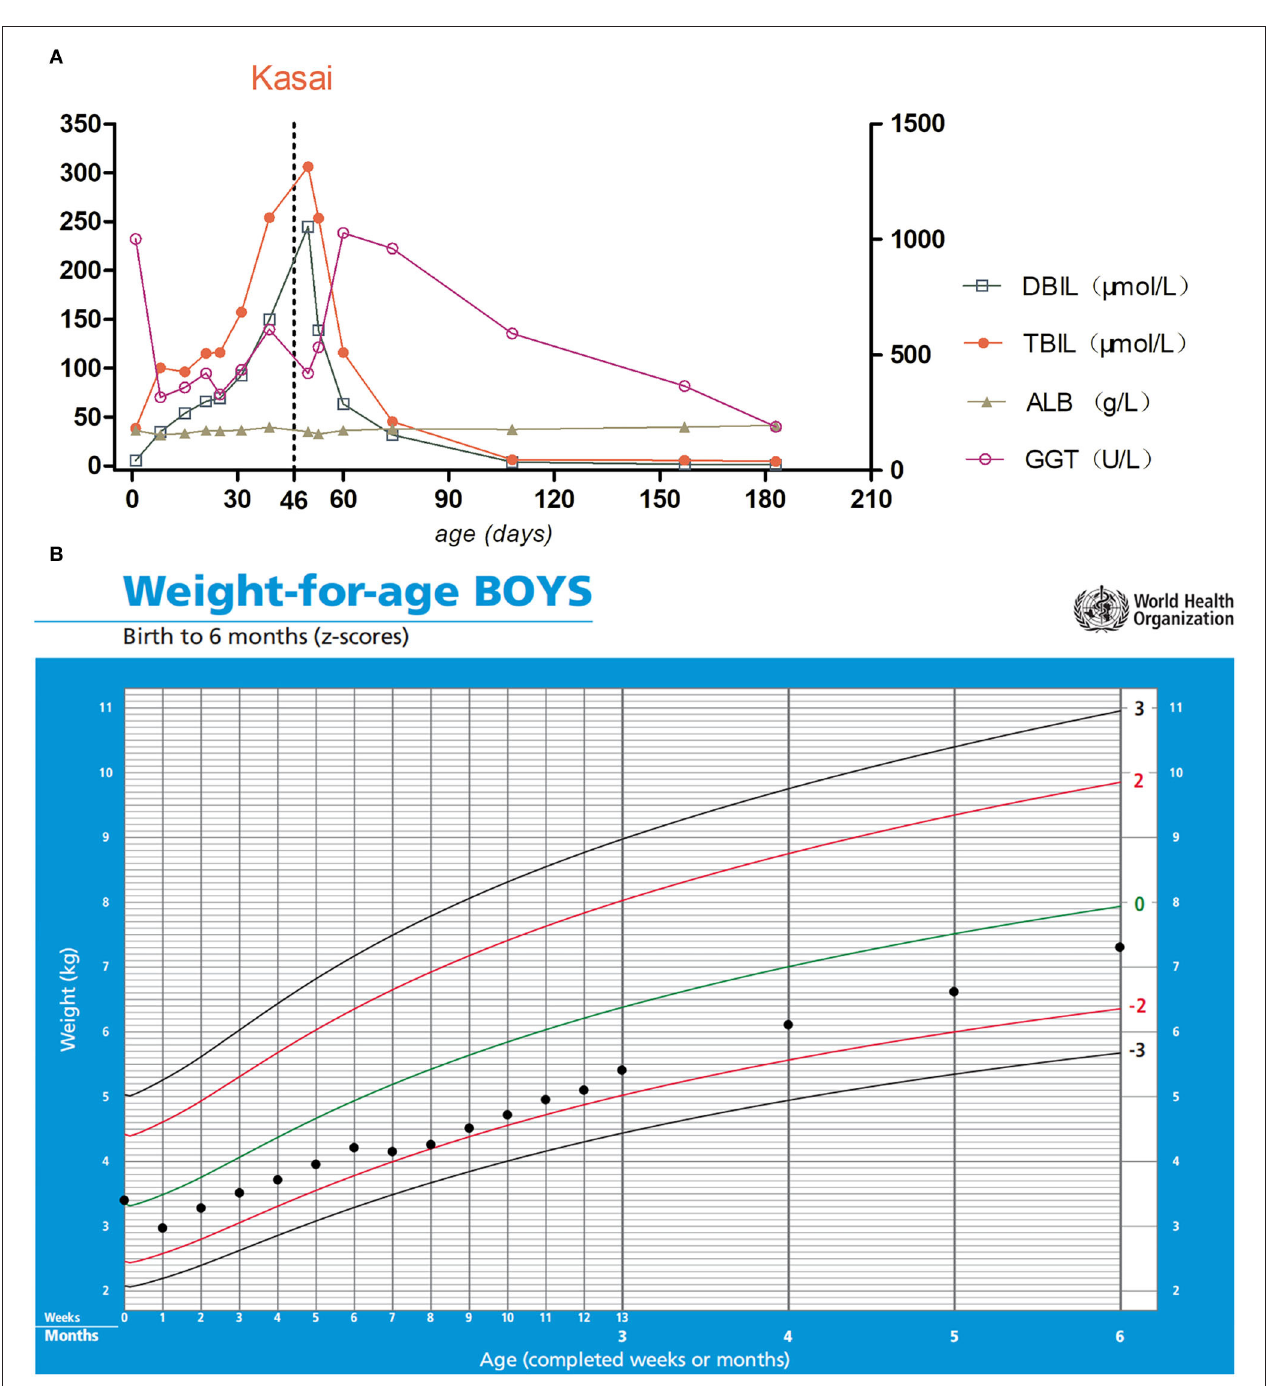
FIGURE 4 | (A) The left Y-axis indicates DBIL, TBIL, and ALB; the right Y-axis indicates GGT. The day of Kasai’s surgery is marked with the vertical dotted line. (B) Growth curve of the patient. Parenteral nutrition was used during hospitalization. After the enterostomy was closed, his weight gradually approached the normal range after